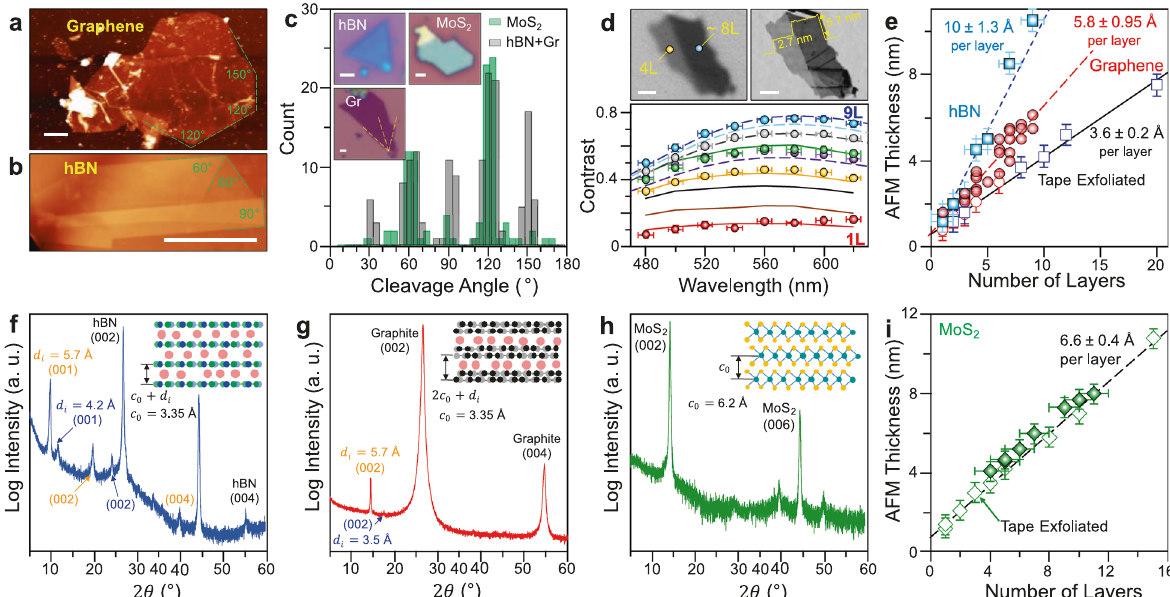
Fig. 4 Signs of the acid intercalation of the 2D sheets. An AFM image of exfoliated graphene ( a ) and hBN ( b ) revealing cleaving edges (marked with green dashed lines). c The histogram of the cleaved edge angles for the exfoliated graphene, hBN (grey), and MoS 2 (green). Insets: Corresponding examples of the exfoliated 2D sheets. d The wavelength dependence of the optical contrast for tape (solid curves) and acid-assisted (circles) exfoliated graphene 2D sheets with a different number of layers. Error bars represent one standard deviation. Dashed curves represent the prediction of the Fresnel law. Inset: Optical (left) and AFM (right) images of the graphene sheet. Scale bars in a – c : 1 µm. e AFM thickness versus the number of layers determined from the optical contrast of the tape exfoliated graphene and hBN (open symbols) compared to the acid-exfoliated graphene (solid circles) and hBN (solid squares). The linear regressions determine the effective monolayer thickness. XRD pattern of exfoliated hBN ( f ) and graphene ( g) exhibiting the re fl ections expected for the bulk crystals (black font) along with the series re fl ections correspondent to the Stage I in hBN and Stage II in graphene intercalated nanosheets with the effective d -spacing, d ¼ nc 0 þ d i , where c 0 ¼ 3.35 Å, n is the stage number and d i is the intercalant size. The re fl ection at around 44° originates from the metallic sample holder. h XRD data for the exfoliated MoS 2 . i AFM thickness for tape (open symbols) and acid-assisted (solid symbols) exfoliated MoS 2 vs. the number of layers determined from the contrast measurements and corresponding linear regression. Error bars in e and i are one standard deviation approximated from AFM height pro fi les (Supplementary Fig. 10) and Fresnel-law model analysis (Supplementary Figs 11 and